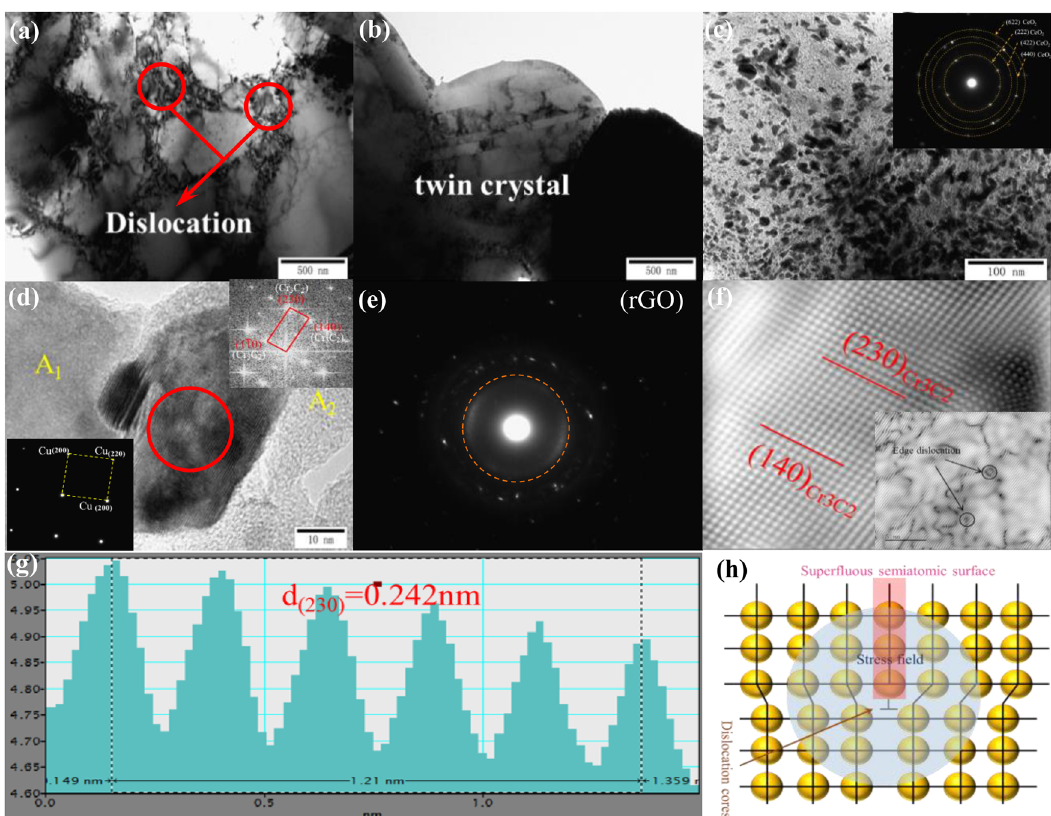
Figure 6: TEM and HRTEM images of 0.5GO/0.5CeO 2 – Cu30Cr10W composite; ( a – c ) bright fi eld image; ( d and f ) HRTEM and di ff raction spots image of Cr 3 C 2 and Cu; ( e ) dark fi eld image showing the rGO; ( g ) gray - scale spectrogram of vertical direction of crystal plane; and ( h ) diagram of edge